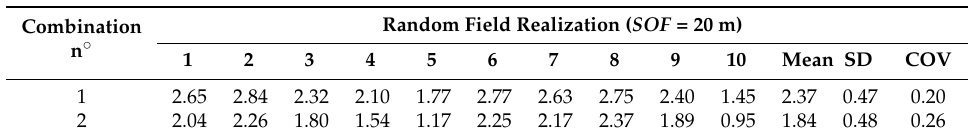
Table 19. Factors of safety results for spatially varied strength parameters with scale of fluctuation of 20